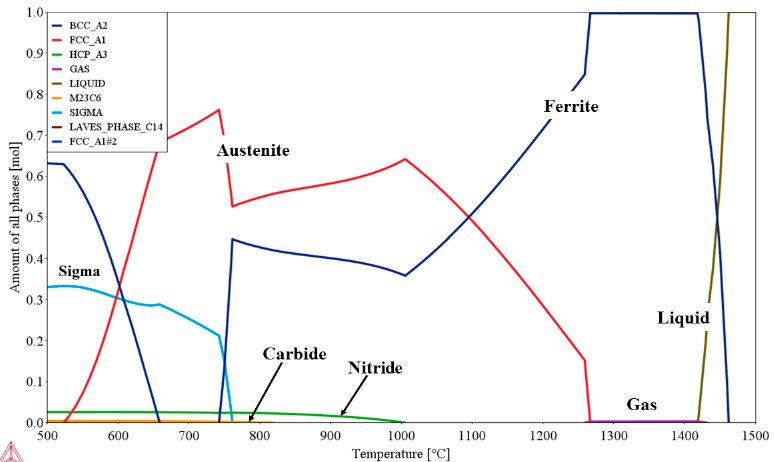
Figure 4. Property diagram of S32101 DSS calculated using Thermo-Calc showing the changes in all phases with temperature under equilibrium conditions.